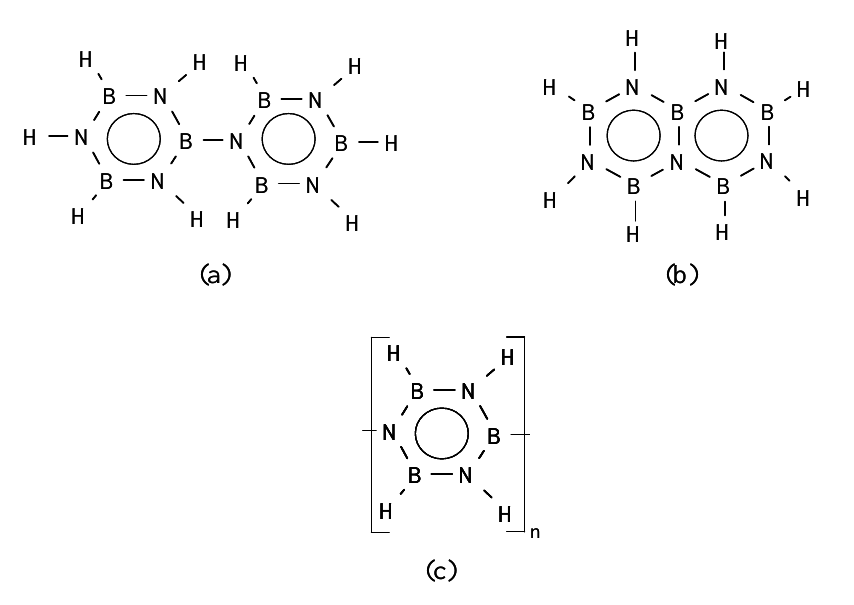
Figure 3. ( a ) Biphenyl and ( b ) naphtalenic-type units generated during the self-condensation of borazine leading to ( c ) polyborazylene